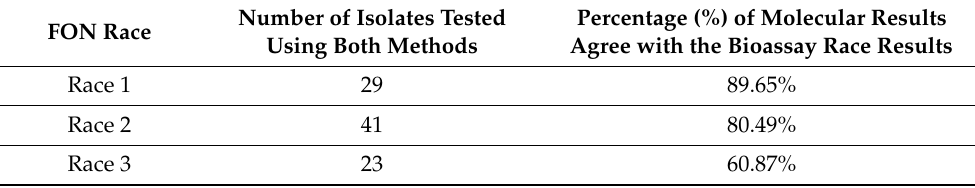
Table 1. Percentage of agreement for race differentiation using bioassay vs. molecular